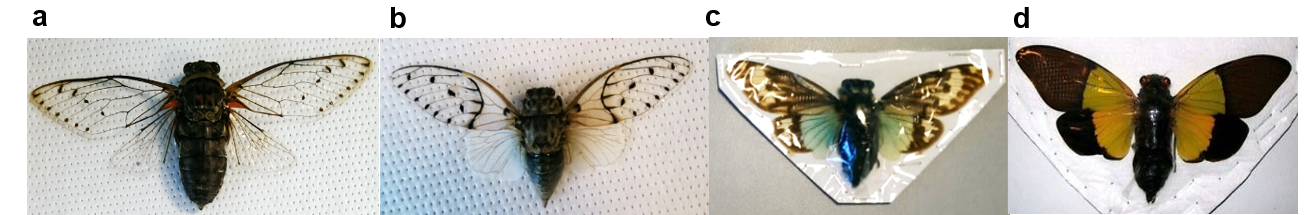
Figure 1. Photos of the cicada wings used in this work: ( a ) Megapomponia intermedia (ME); ( b ) Ayuthia spectabile (AY); ( c ) Tosena splendida blue (TO); ( d ) Trengganua sibylla (TR).